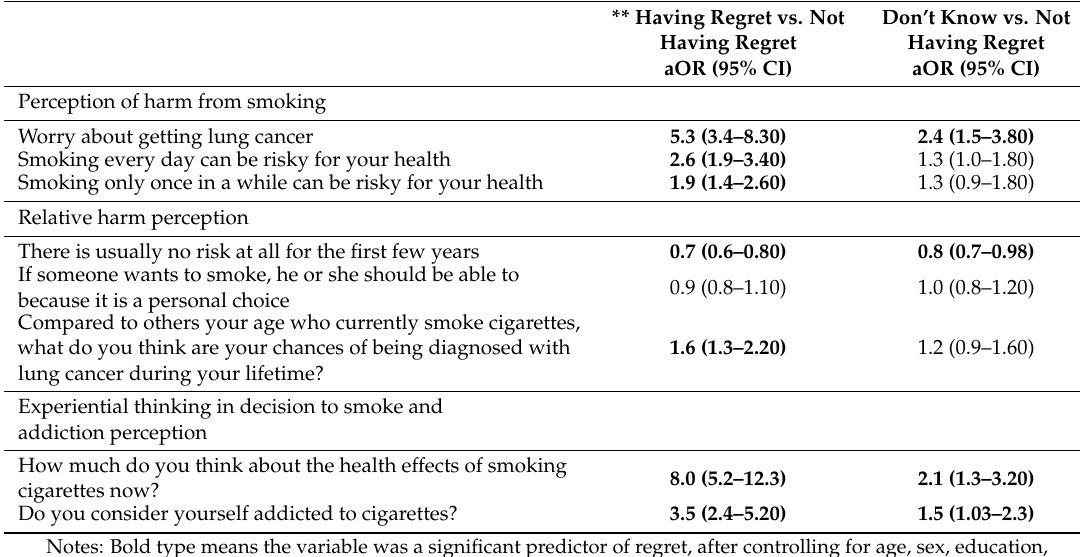
Table 2. Multinomial logistic regression analysis assessing predictors of regret.